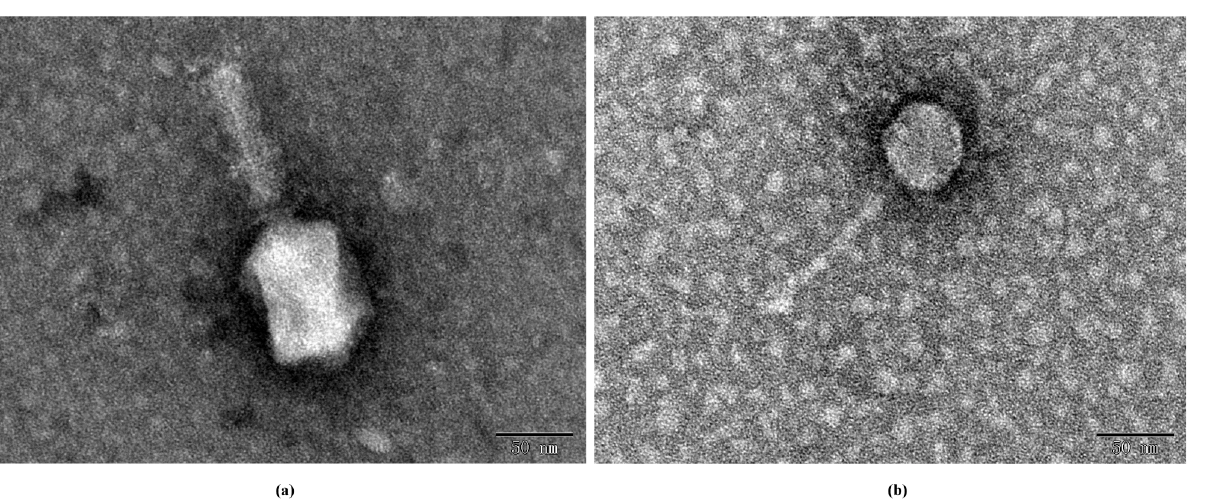
Figure 2. TEM of phages. ( a ) phage PSE-D1. ( b ) phage PST-H1.